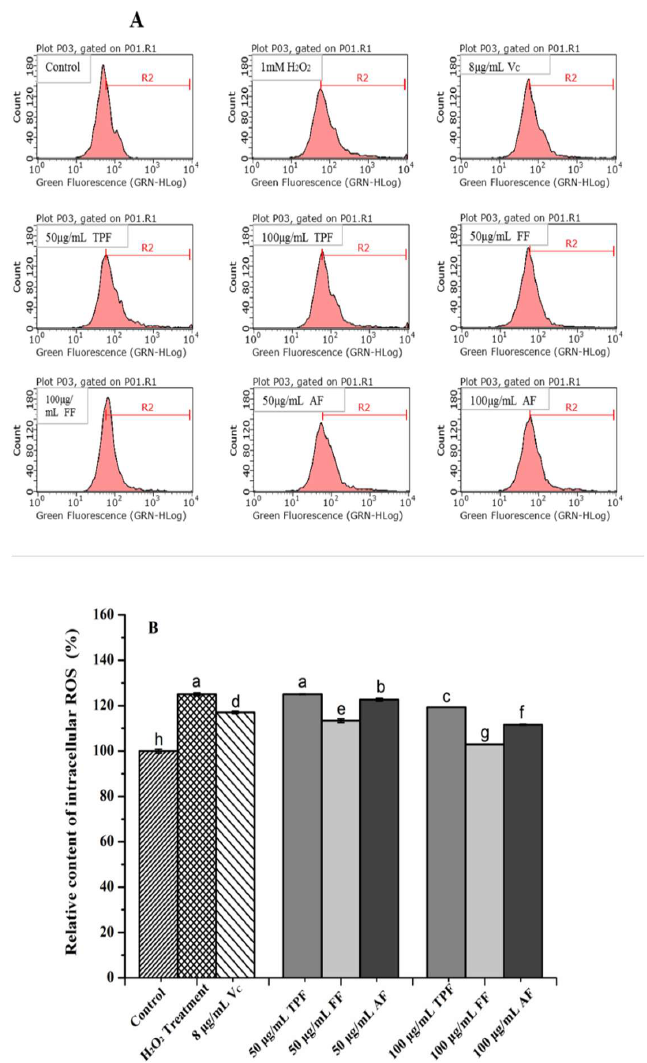
Figure 3. The results of cellular reactive oxygen species (ROS) inhibitory effects of the different fractions from P. utilis fruits in H 2 O 2 -induced HepG2 cells: Flow cytometry analysis ( A ) and the relative amount of ROS in different groups ( B ). Means (bar value) with different letters are significantly different ( p < 0.05).